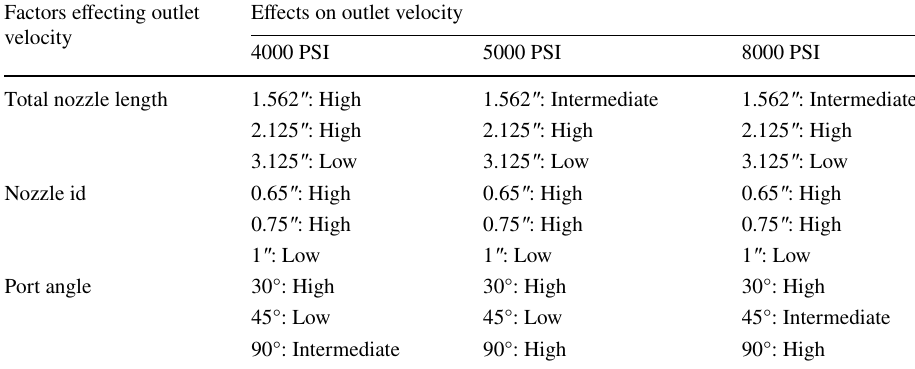
Factors effecting outlet